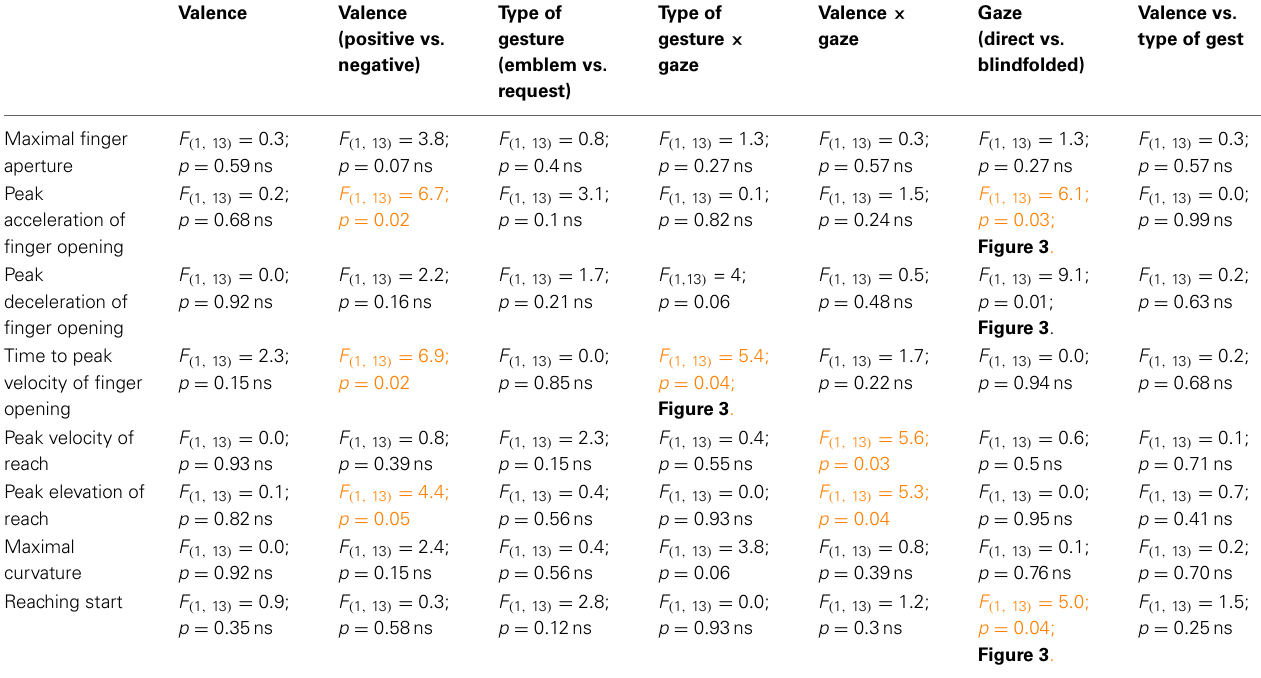
Valence Valence